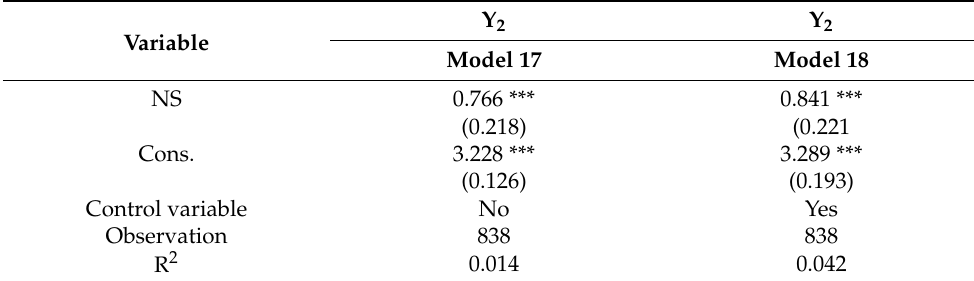
Table 7. Regression results from replacing explained variables. Y 2 Y 2 Variable Model 17 Model 18 NS 0.766 *** 0.841 *** (0.218) (0.221 Cons. 3.228 *** 3.289 *** (0.126) (0.193) Control